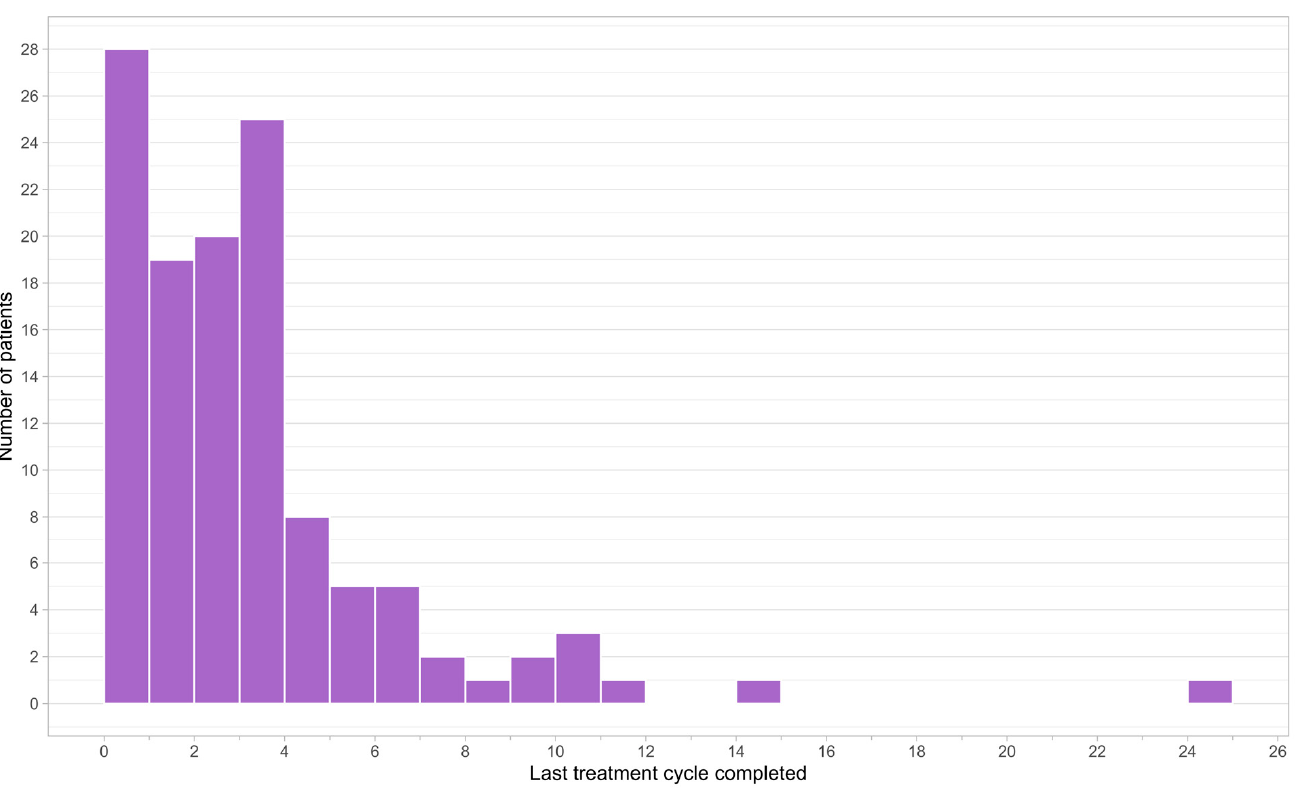
Figure 2. Frequency histogram of treatment duration of patients who received trifluridine/tipiracil. The primary reasons for never having started FTD/TPI treatment at the data cut- off date were death (25.6%, n = 10) and physician decision (23.1%, n = 9) (Table 2). For patients who started FTD/TPI, the primary reasons for treatment discontinuation were disease progression (52.1%, n = 63) and death (20.7%, n = 25). A total of 3.7% (n = 6) of patients were also enrolled in the Health Canada Special Access Program. Almost half (43.9%, n = 69) of patients received FTD/TPI treatments that were reimbursed by